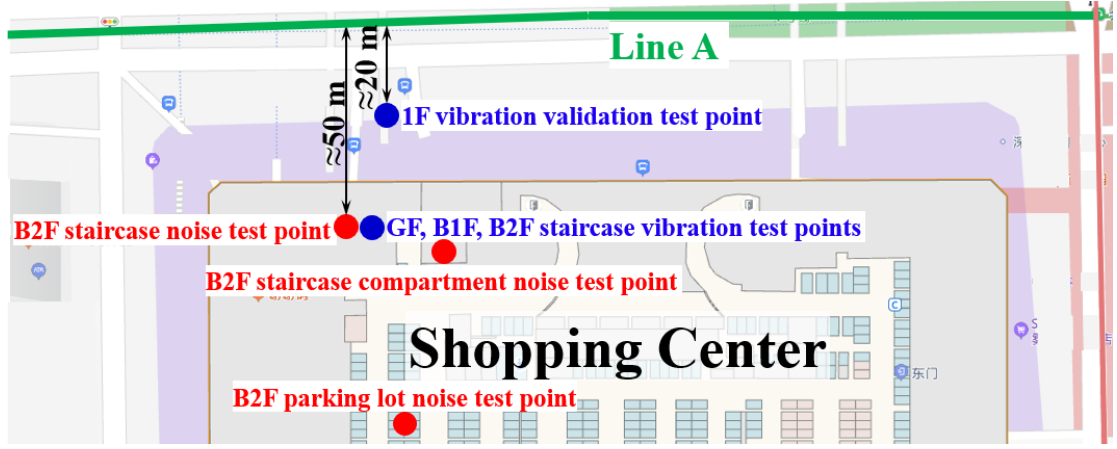
Sensors 2023 , 23 , x FOR PEER REVIEW Figure 11. Test points set up in the public area of the shopping center. Figure 11. Test points set up in the public area of the shopping center.